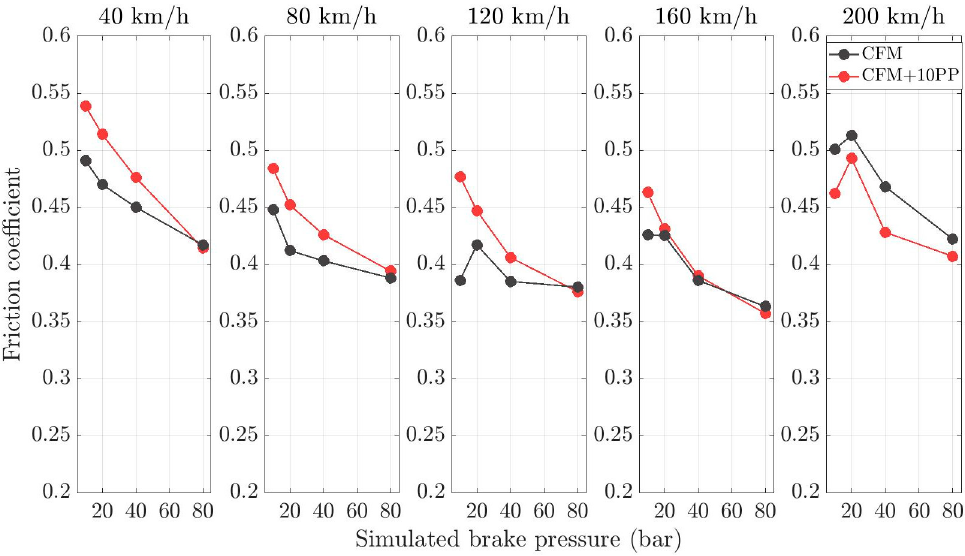
Figure 8. Typical behavior of the friction coefficient at different pressure and velocity during the speed-pressure sensitivity sections of SAE J2522 for the tested friction materials of CFM and CFM with 10 PP waste addition.